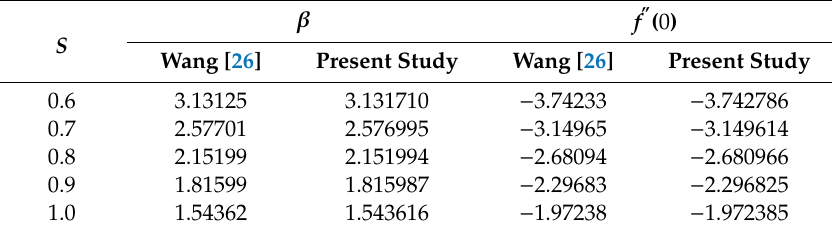
Table 1. Comparison values of β and f (cid:48)(cid:48) ( 0 ) when Pr = n = 1 and We = S = M = 0. β f ” ( 0 ) S Wang [26] Present Study Wang [26] Present Study